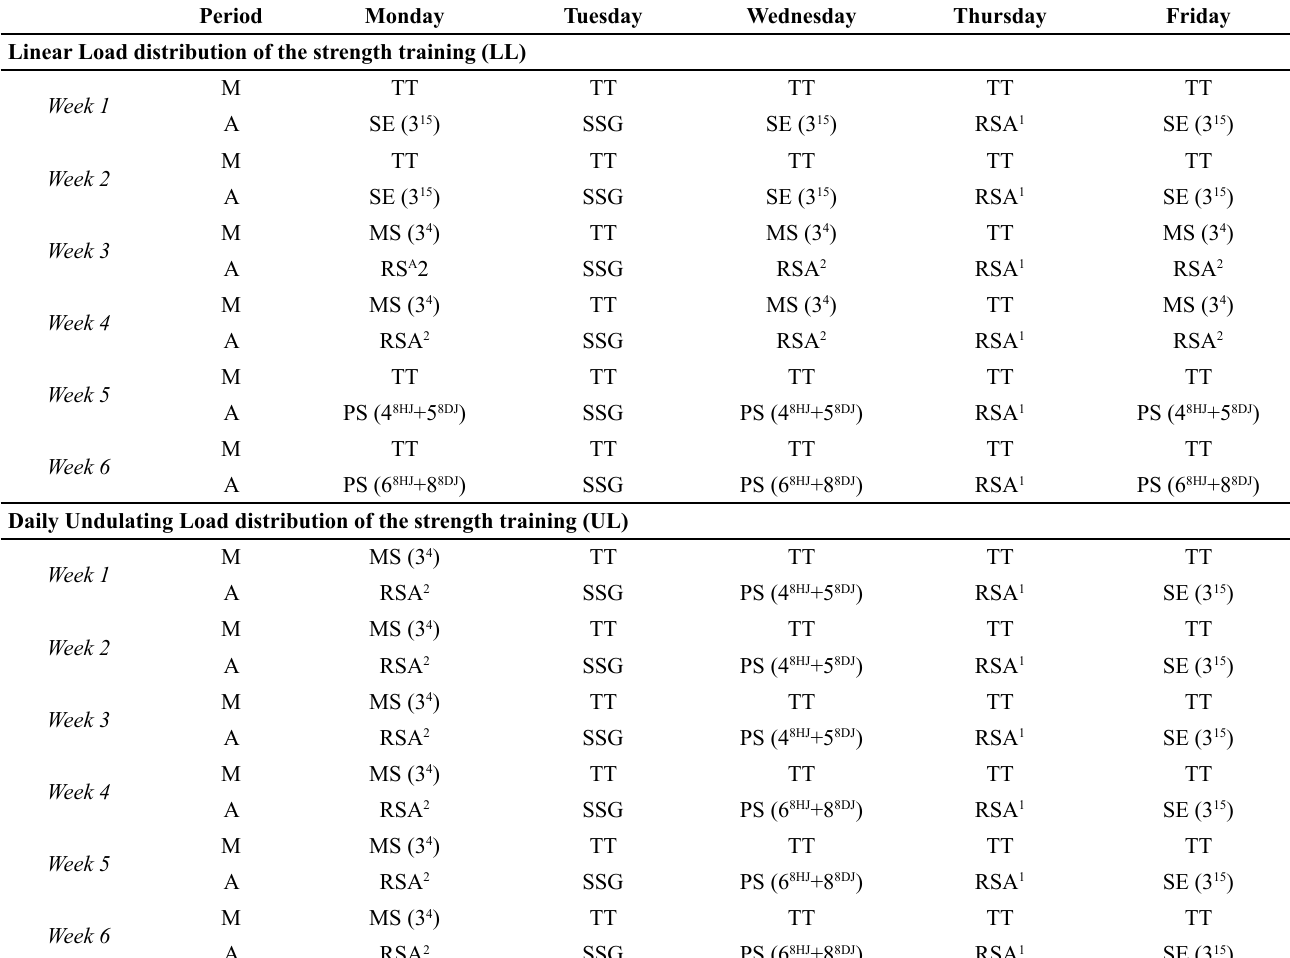
Table 2. Distribution of training sessions for the Linear Load and Undulating Load groups.